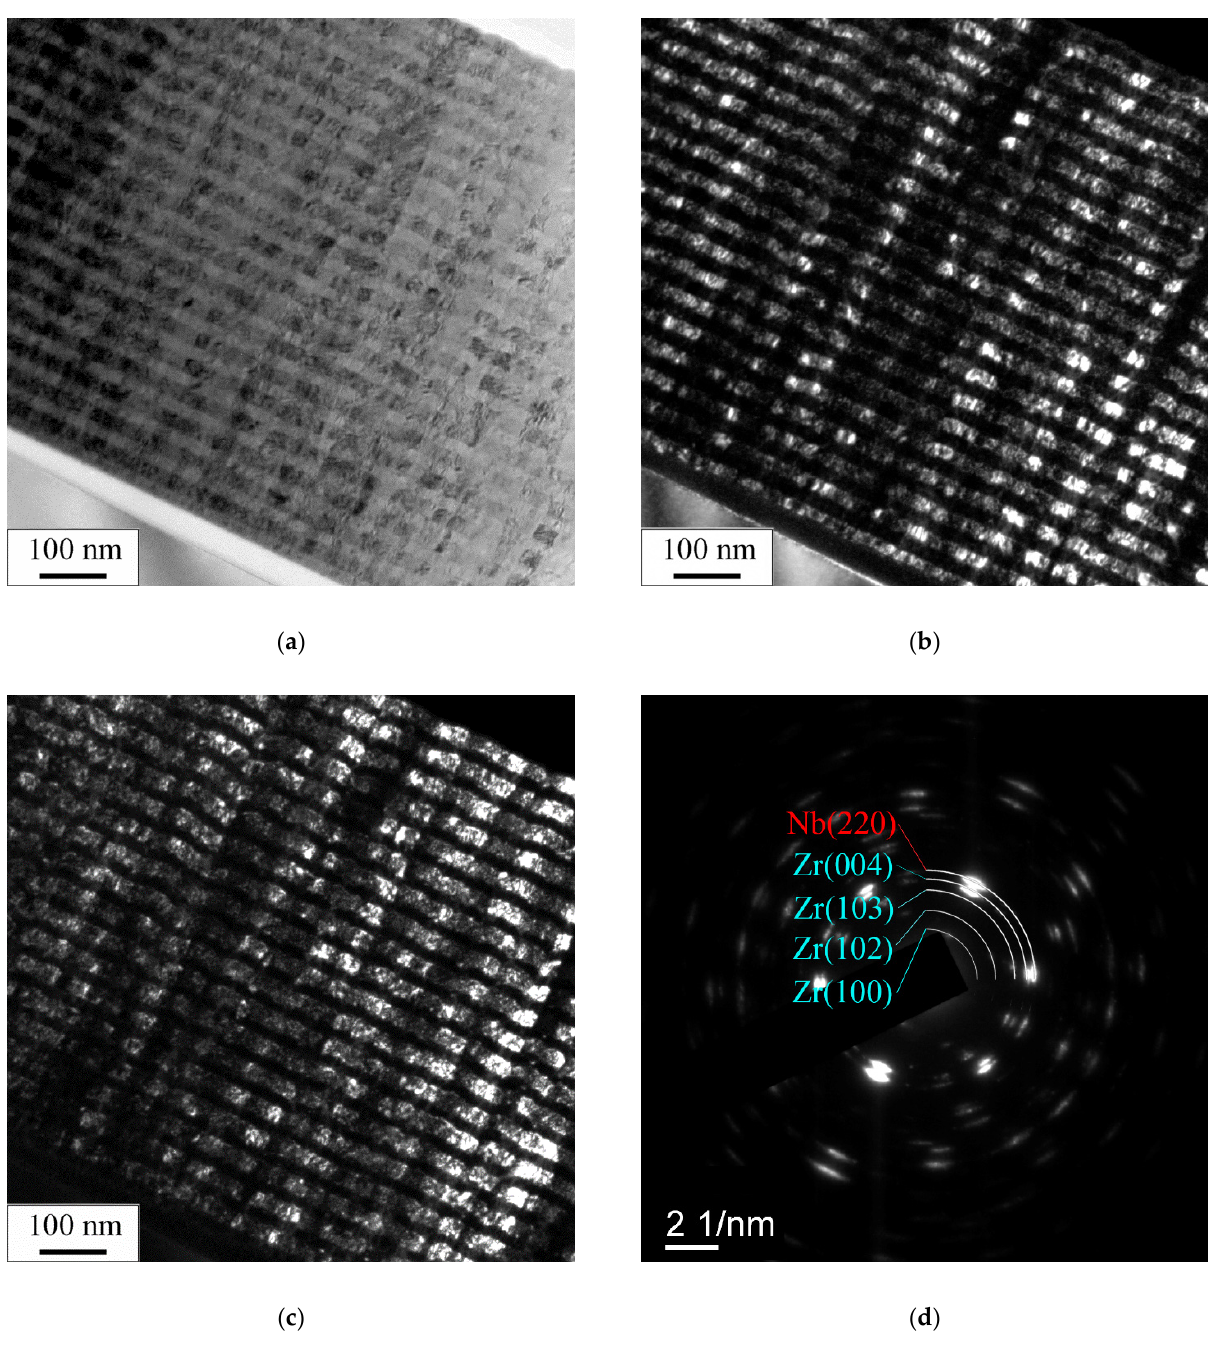
Figure 3. TEM images of the microstructure of the Zr/Nb NMC cross-section on the example of coatings with individual layer thickness 25 nm: bright-field image ( a ), dark-field images in (004) Zr α reflection ( b ), and (220) Nb β reflection ( c ), as well as corresponding SAED ( d ).